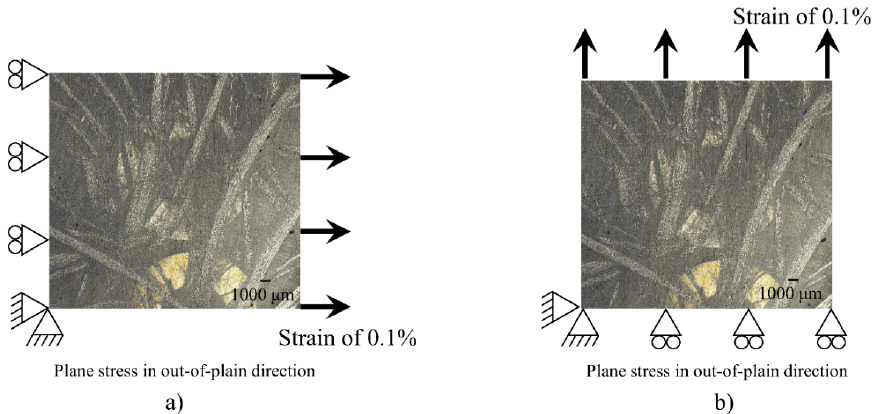
Figure 7. Boundary and loading condition for one of the original images collected through optical microscopy with a magnification of 100×. This sample areal fiber fraction is ~33%; ( a ) Left boundary fixed, lower left and bottom node fixed and constant force applied from the right hand side to cause a strain of 0.1% in the x axis direction in a Cartesian coordinate system, and ( b ) Lower boundary fixed, lower left and bottom node fixed and constant force applied from the top side to cause a strain of 0.1% in the y axis direction in a Cartesian coordinate system.